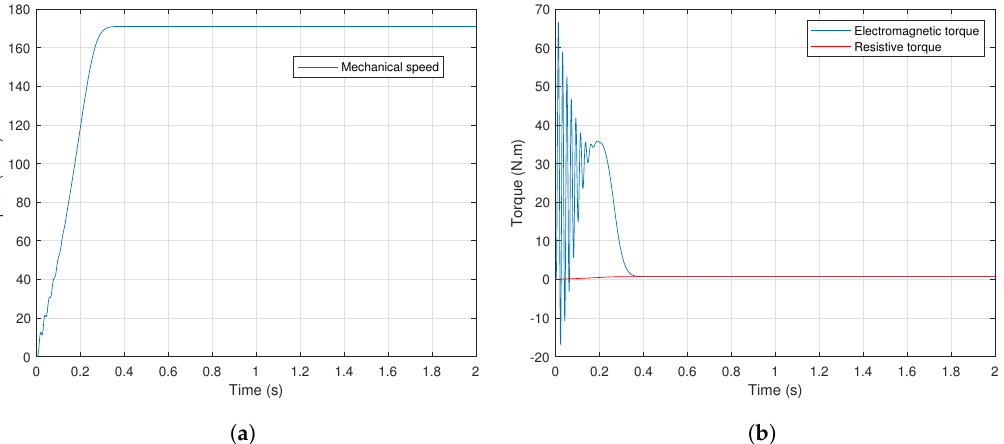
Figure 2. Start-up and steady-state of the induction motor. ( a ) Start-up: mechanical speed; ( b ) start-up: electromagnetic